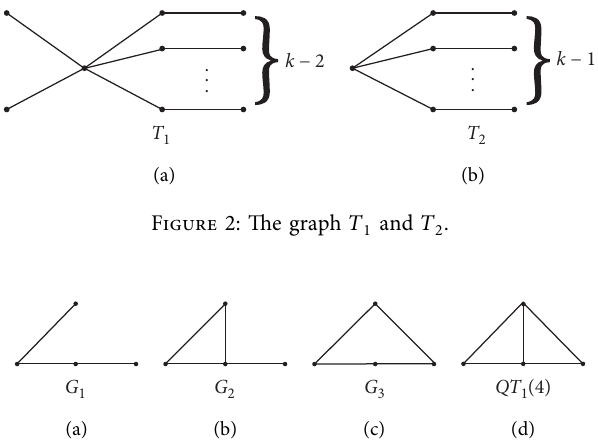
Figure 3: The graph G